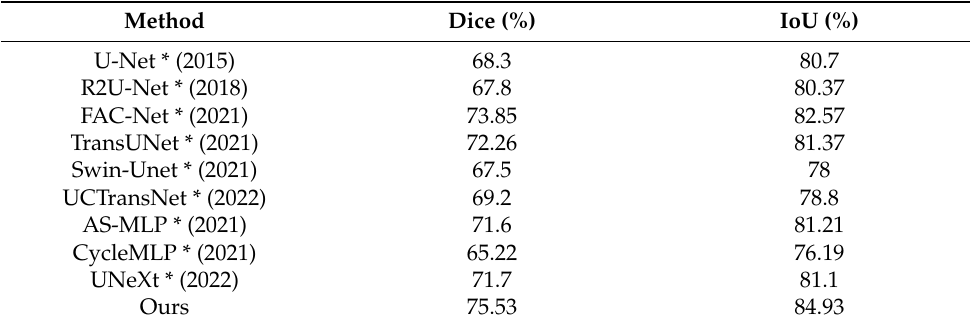
Table 6. ISBI2017 evaluation indicators of each comparison